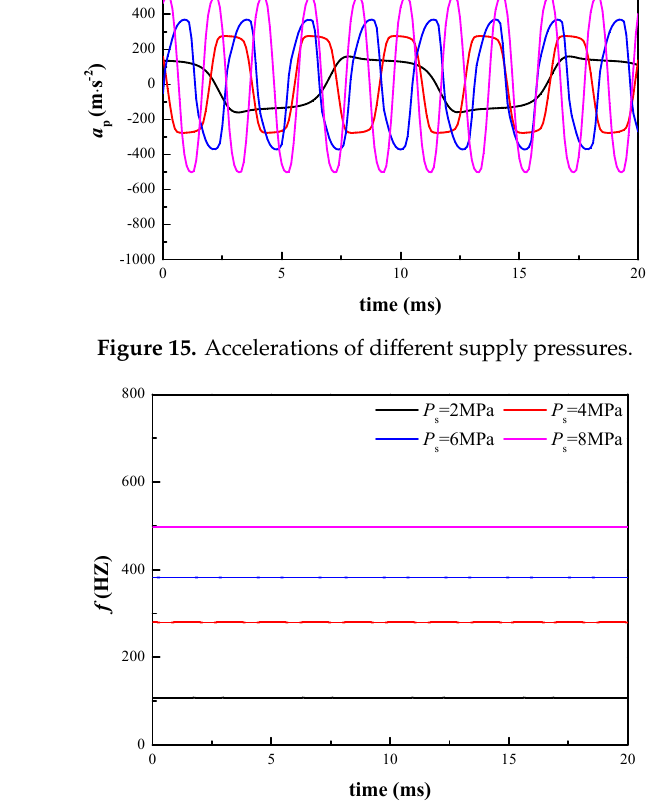
Figure 16. Reversing frequencies s of di ff erent supply